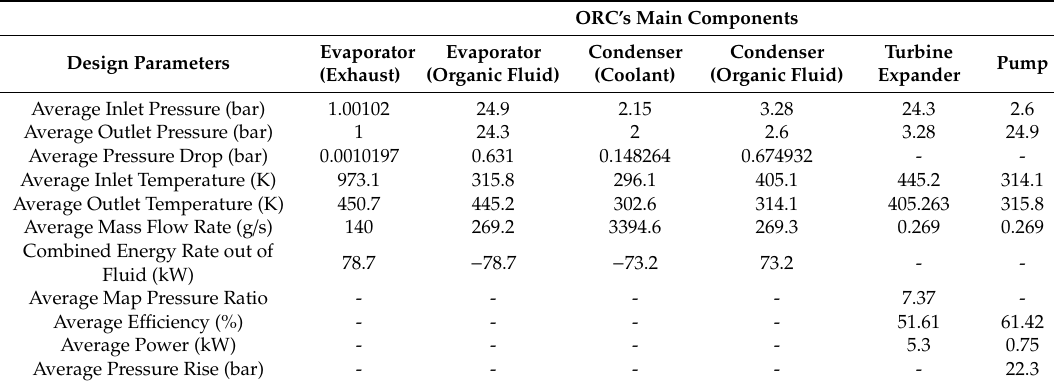
Figure 7. ORC system model in GT-Power. Table 2. Component design parameters of ORC using R245fa refrigerant.